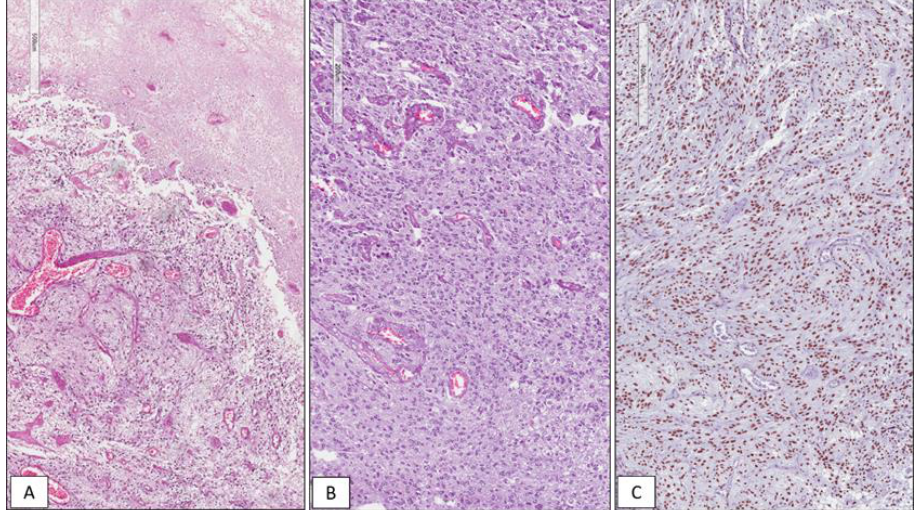
Figure 1. WHO grade IV IDH wild type glioblastoma. Histopathological examination showing a hypercellular glial tumor with extensive necrosis ( A ) and microvascular proliferation ( B ); high immunohistochemical nuclear expression of SRSF1 in a GBM tissue sample ( C ) (hematoxylin and eosin( A , B ) and immunoperoxidase ( C ) staining; original magnifications 50×, 100× and 100×).